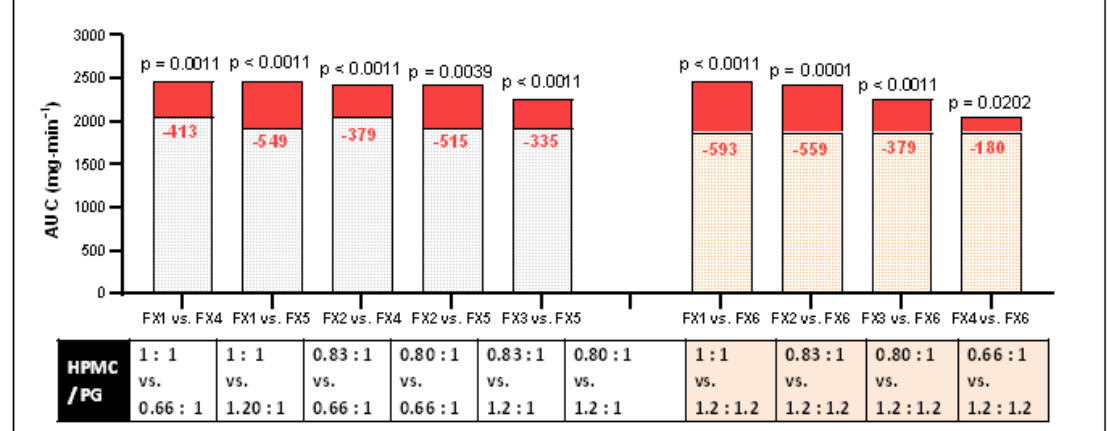
Figure 7. Formulations with statistically different dissolution profiles.